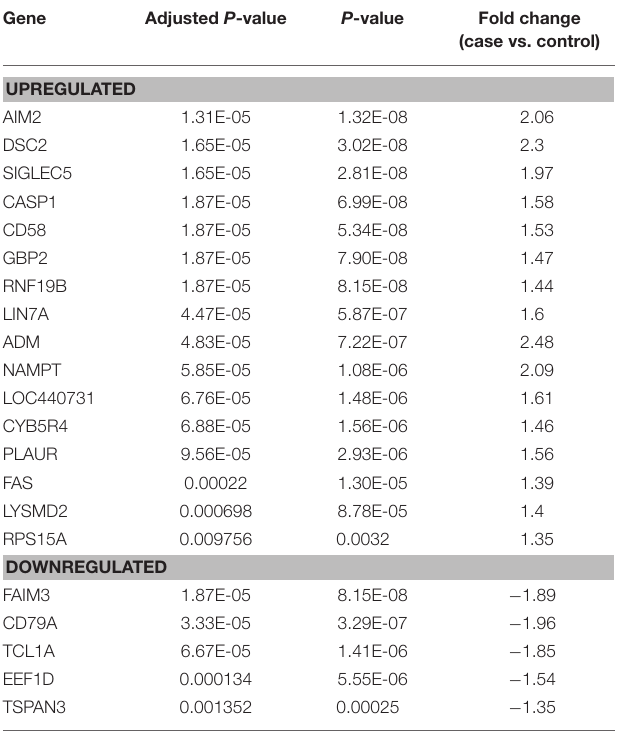
TABLE 2 | A list of 21 classifiers of STI PID using blood gene expression arrays.